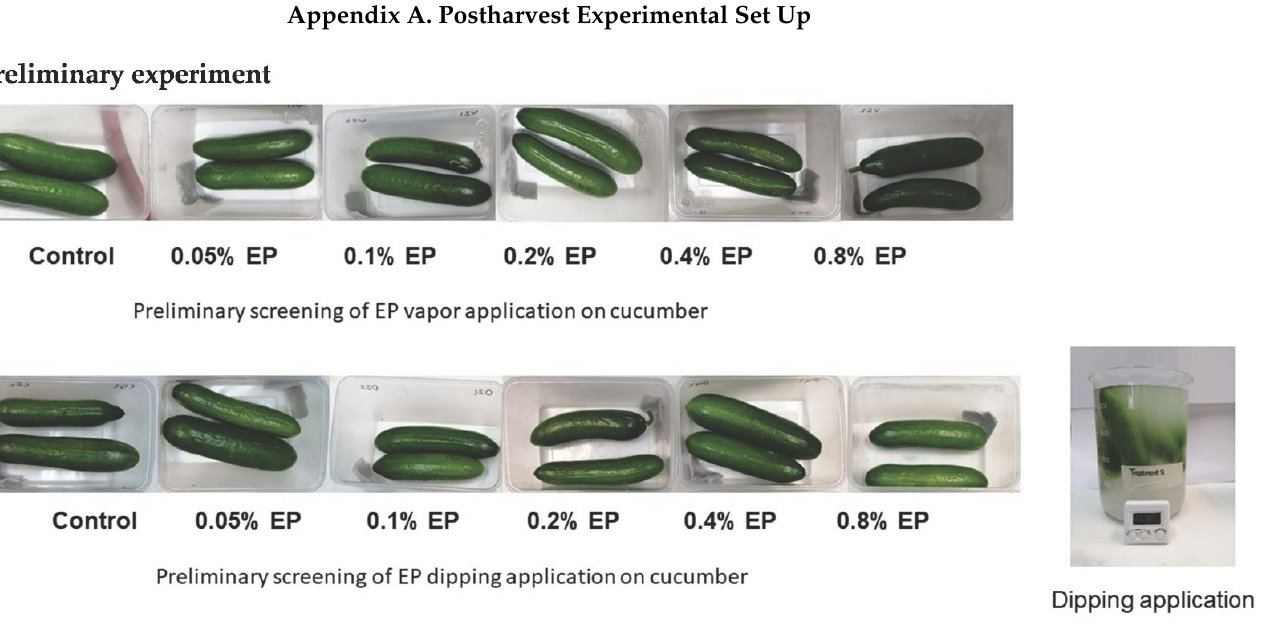
Figure A1. Preliminary screening of EP applications.